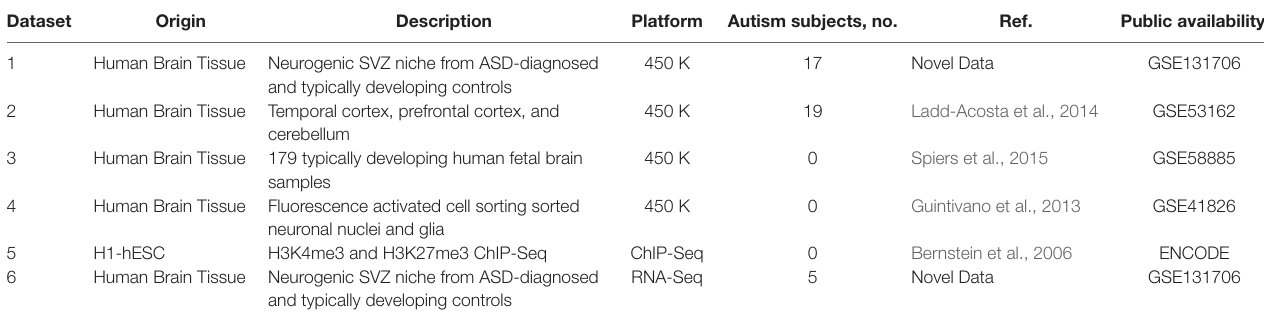
TABlE 1 | Overview of